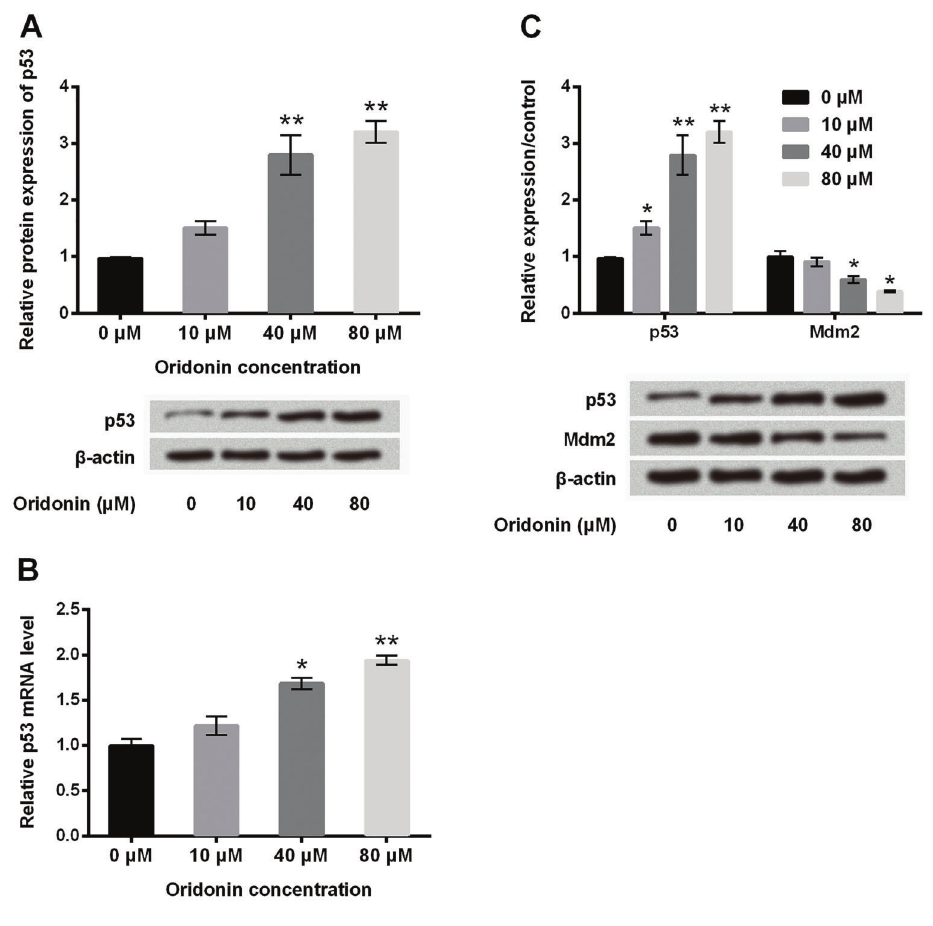
Figure 4. Oridonin enhanced p53 expression by inhibition of Mdm2 in SNU-216 cells. SNU-216 cells were exposed to oridonin (0, 10, 40, and 80 m M) for 24 h. The protein ( A ) and mRNA ( B ) expressions of p53, and the protein expressions of p53 and Mdm2 ( C ) were determined by western blot. Data are reported as means ± SD. *P o 0.05, **P o 0.01 compared to 0 m M (ANOVA).